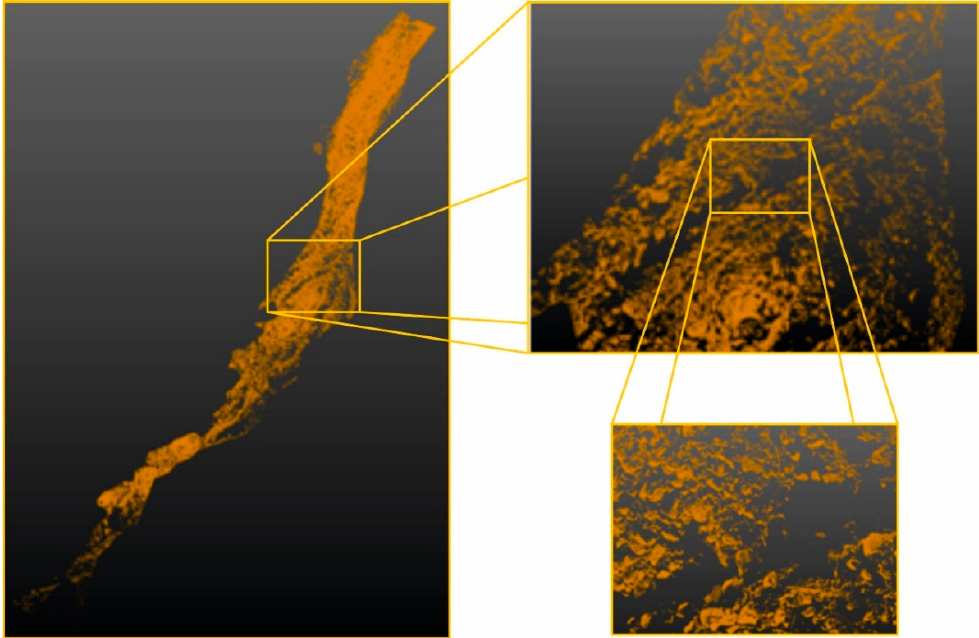
Figure 10. Terrestrial laser scanner (TLS) point cloud—overall view and details.